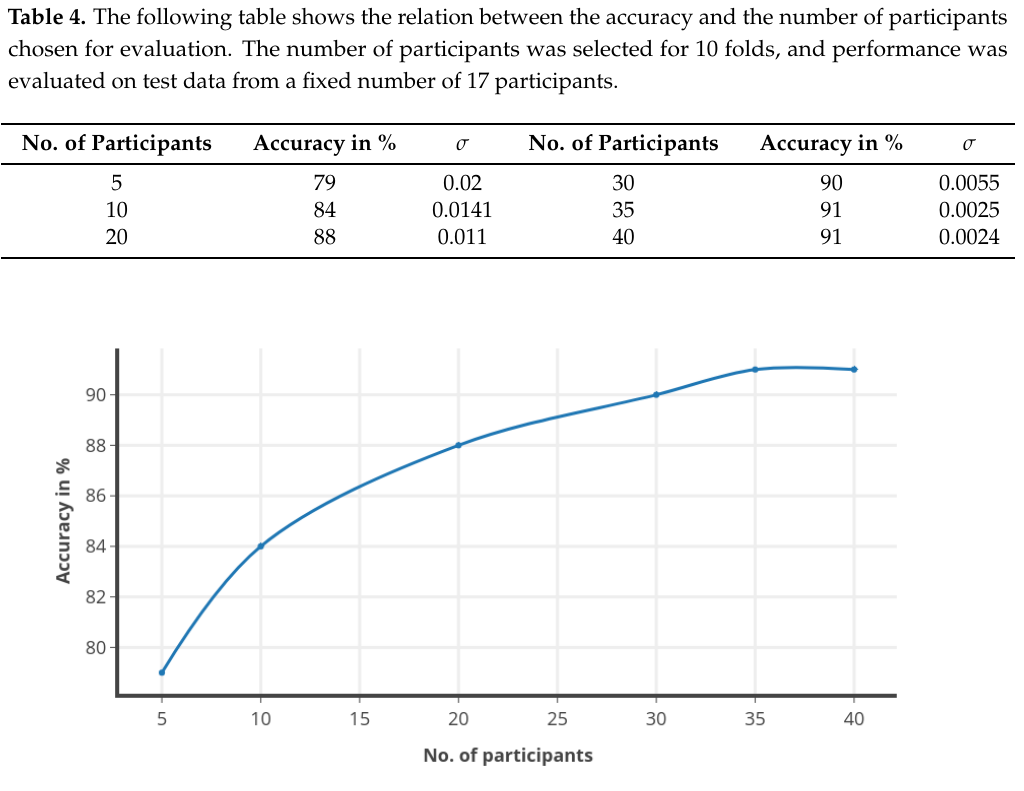
Figure 10. The relation between the number of participants’ data and the accuracy. For an accuracy of 90% or above, a minimum of 30 participants were needed for our